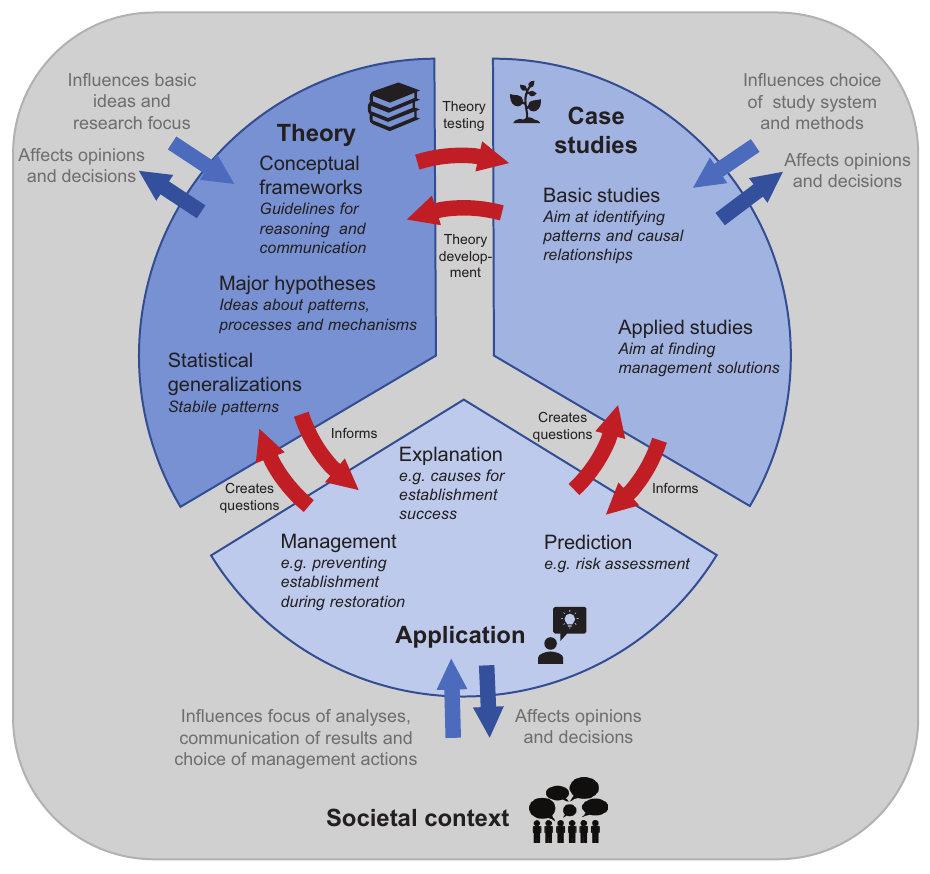
Figure 2. Invasion biology, with its building blocks theory, cases studies and application, is embedded in a societal context. The red arrows show how theory, case studies and application affect each other; the blue arrows depict effects of society on invasion biology and vice versa. The lighter colour of the block ‘applica- tion’ indicates that also non-biological questions beyond invasion biology, as defined above, are addressed here – these are part of invasion science (see Fig.